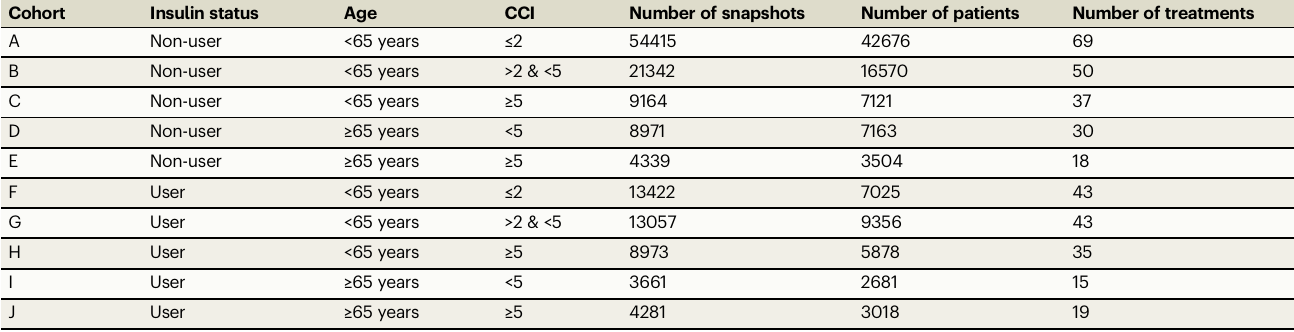
Table 1 | De fi nitions and characteristics of T2DM patient